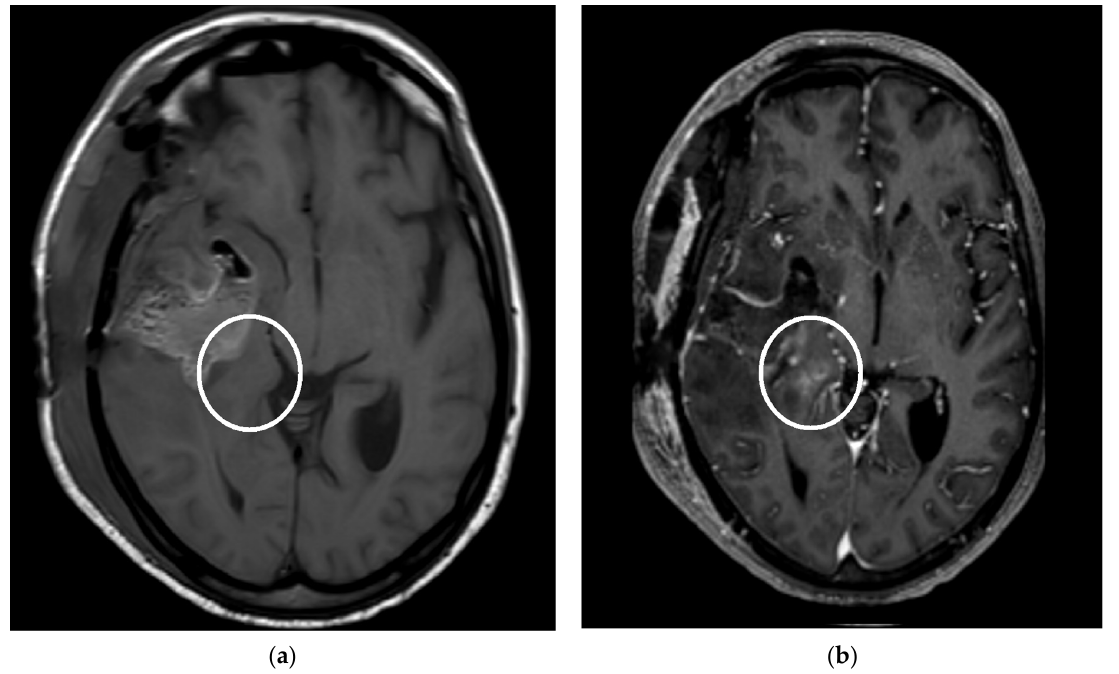
Figure 2. Patient undergoing neurosurgical resection of glioblastoma multiforme in the right temporal site; MRI follow-up 40 h after surgery. ( a ) The T1-weighted image without contrast medium shows surgical sequel with pneumocephalus and inhomogeneous hyperintense signal at T1, with the possible expression of methemoglobin deposits. ( b ) The T1-weighted with contrast medium shows nodular contrast enhancement at the uncus of the parahippocampal gyrus; the match is compatible with residual glioblastoma multiforme (white circle).